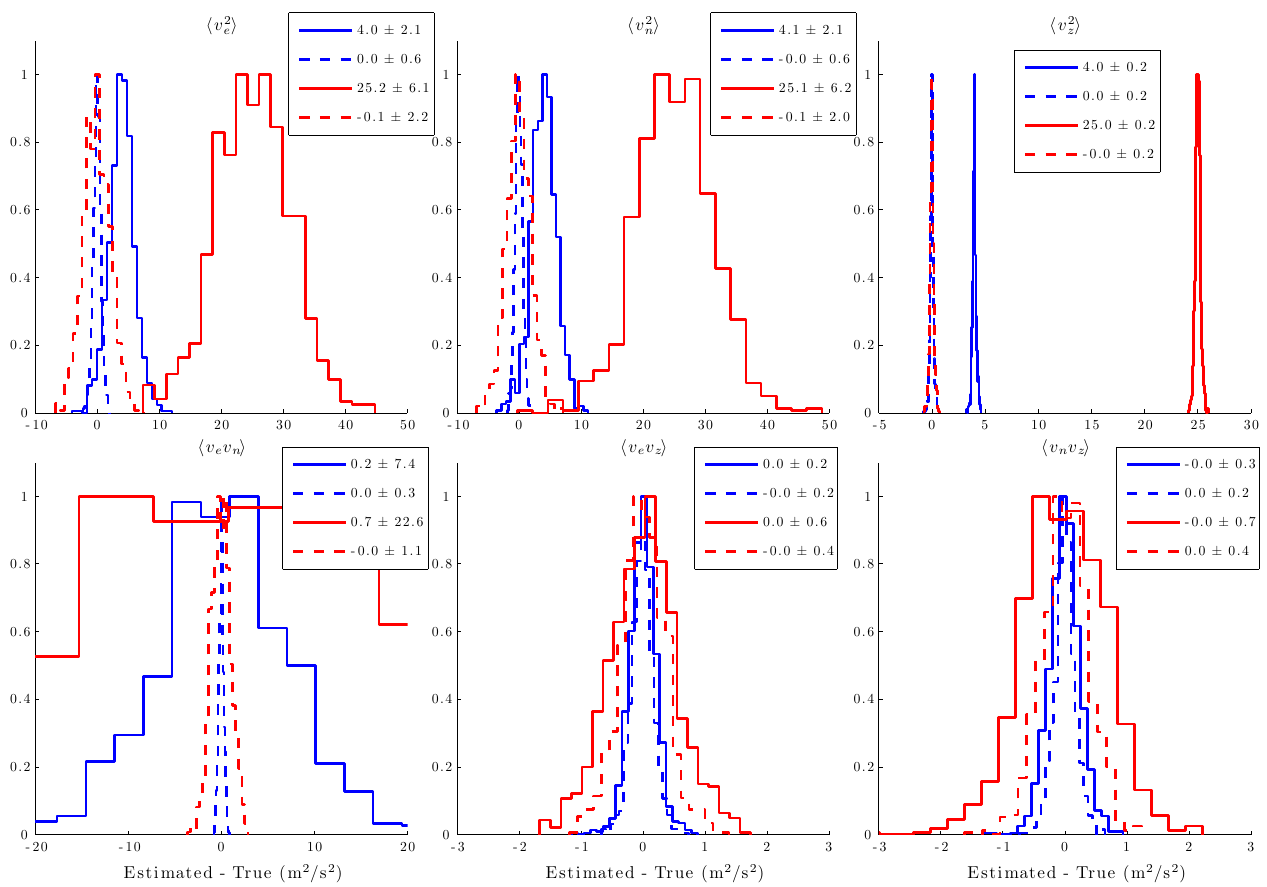
Fig. 3. Simulation results. Histograms of the biases (true value subtracted from the mean result of the simulation over N 2 iterations) for each wind field variance/covariance measurement. Blue lines correspond to σ e = 2ms − 1 and red lines correspond to σ e = 5ms − 1 . Solid lines correspond to the standard momentum flux approach, neglecting the covariance terms. Dashed lines follow the approach outlined in this paper including the covariance terms and subtracting the expected value of the measurement error variances from the estimated variances. Legend values show the median and standard deviation of each